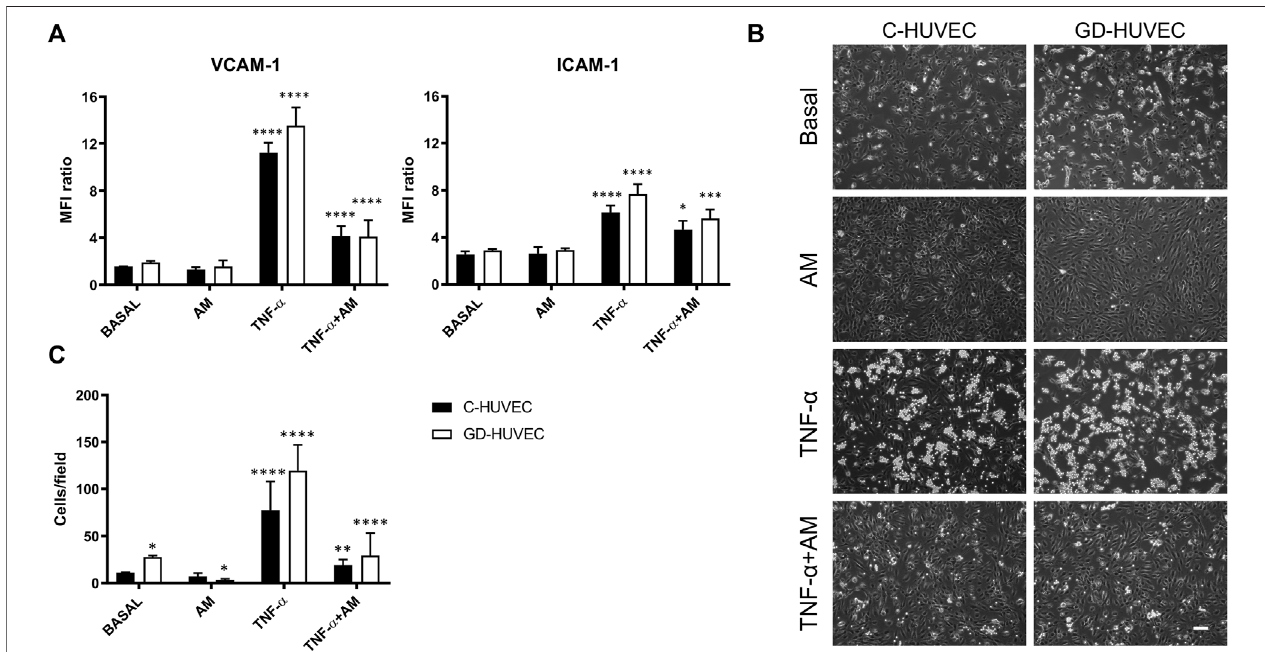
FIGURE 2 | Effect of AM on VCAM-1 and ICAM-1 membrane exposure and TNF- α -induced monocyte adhesion in C- and GD-HUVECs analyzed by fl ow cytometry. (A) VCAM-1 and ICAM-1 membrane exposure in C- and GD-HUVECs untreated (basal) and treated for 16 h with 1 ng/ml of TNF- α with or without AM incubation (24 h). Quantitative data in the histograms show the mean fl uorescence intensity (MFI) ratio between the signal and the background noise. The experiments wereperformedusing fi vedifferentcellularstrainsforC-and fi vedifferentcellularstrainsforGD-HUVECs( n =5).ANOVAandTukey ’ smultiplecomparisontest:* p < 0.05 TNF- α + AM vs. TNF- α ; *** p < 0.001 TNF- α +AM vs. TNF- α ; **** p < 0.0001 TNF- α vs. basal and vs. AM; **** p < 0.0001 TNF- α + AM vs. TNF- α . (B) Monocyte- endothelialcellinteractiononC-andGD-HUVECsuntreated(basal)andincubatedwithAM(24 h)afterTNF- α stimulationfor16 h.RepresentativepicturesofC-andGD- HUVECsforeachexperimentalcondition.Barrepresents100 µm.Quantitativedata,inthehistogram (C) ,showthenumberofadherentU937cellsobtainedbyanalyzing the microscope images of four different cellular strains for both C-HUVECs and GD-HUVECs ( n = 4), each including 12 counts per condition. Each measurement is de fi ned as the mean ± SD of adherent monocytes. ANOVA and Tukey ’ s multiple comparison test: * p < 0.05 basal GD-HUVEC vs. basal C-HUVEC and AM GD-HUVEC vs. basal GD-HUVEC; ** p < 0.01 TNF- α + AM vs. TNF- α ; **** p < 0.0001 TNF- α vs. basal and vs. AM, TNF- α + AM vs. TNF- α